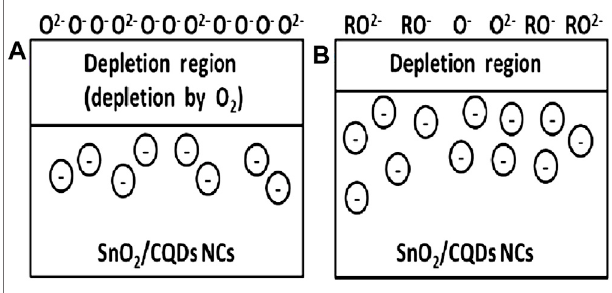
FIGURE 13 | (A) Oxygen extract electrons from metal oxide, thereby decreasingconductivity,and (B) whenreducingagent(R)ispresent,electrons are injected into the oxide again and thus increasing conductivity. Reprinted with permission from Prajapati et al. (2021).